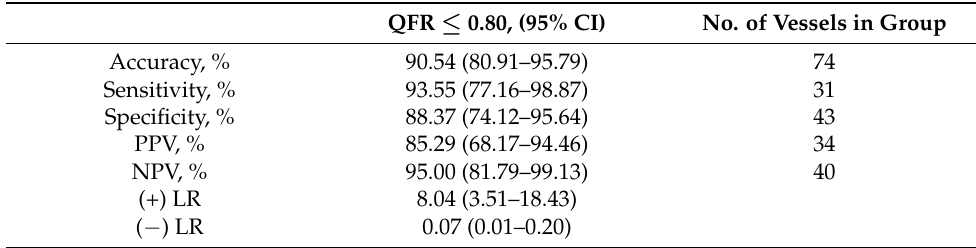
Table 3. Diagnostic performance of OFR.